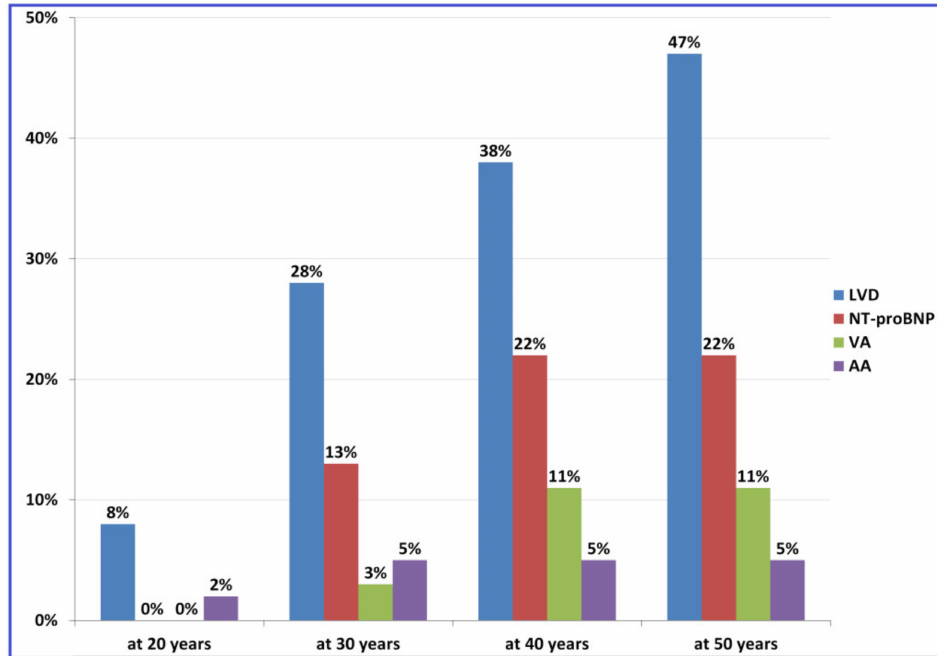
Figure 2. Penetrance of cardiotitinopathy indicators estimated by Kaplan–Meier method in asymp- tomatic TTN tv carriers identified through familial screening. Legend: AA, atrial arrhythmia; LVD, left ventricular dysfunction, NT-proBNP, N-terminal pro-B-type natriuretic peptide serum concentration >125 pg/mL; VA, ventricular